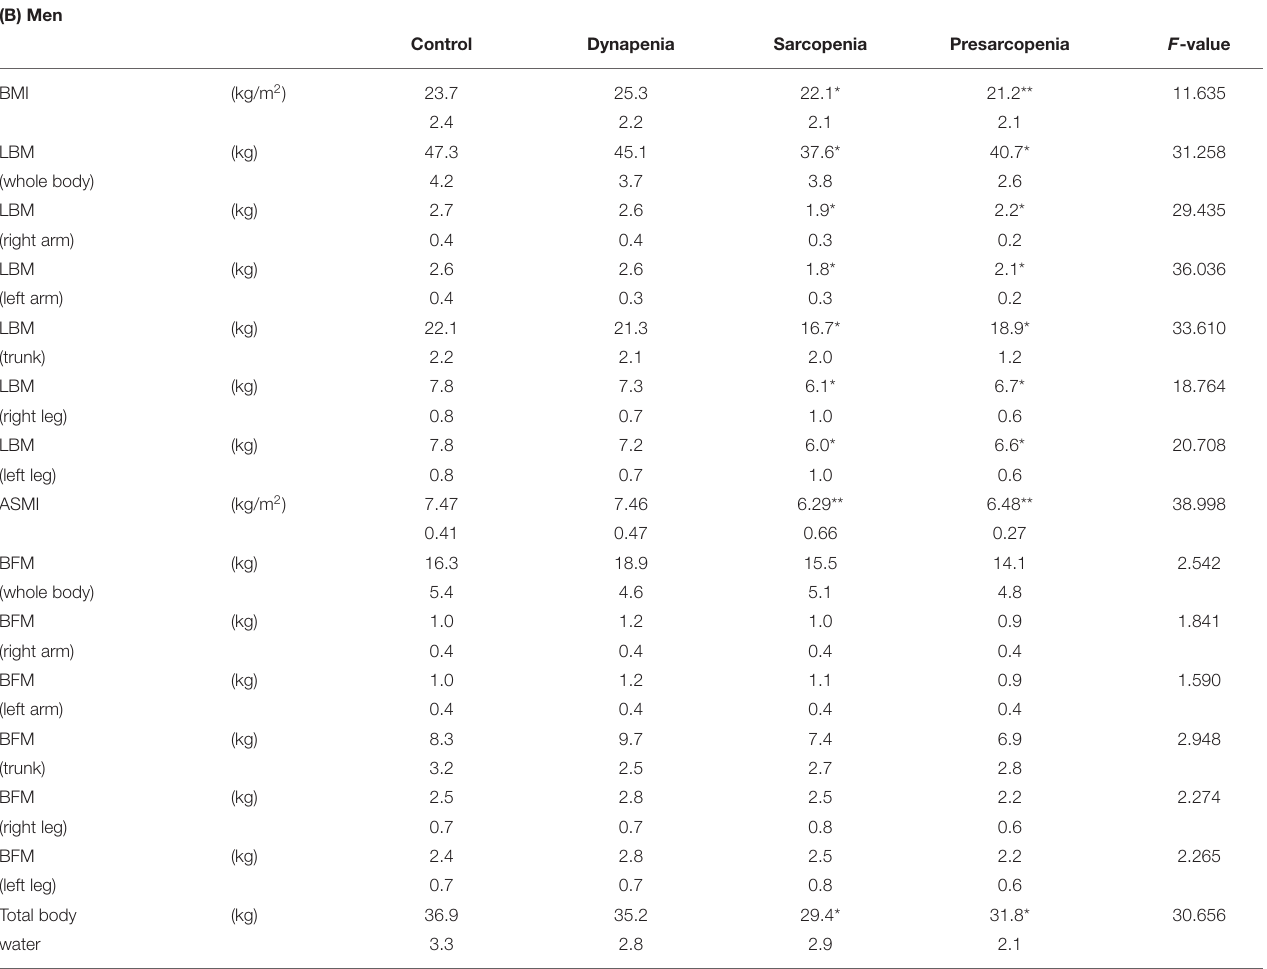
[ F (12) = 9.073, p < 0.01]. The muscle mass of the sarcopenia group both in the arm and leg was less than that of the control group. However, unlike in women, no significant differences in the arm and leg muscle mass were detected between the control and dynapenia groups. Instead, BFM was higher in the leg in the dynapenia group compared to the control